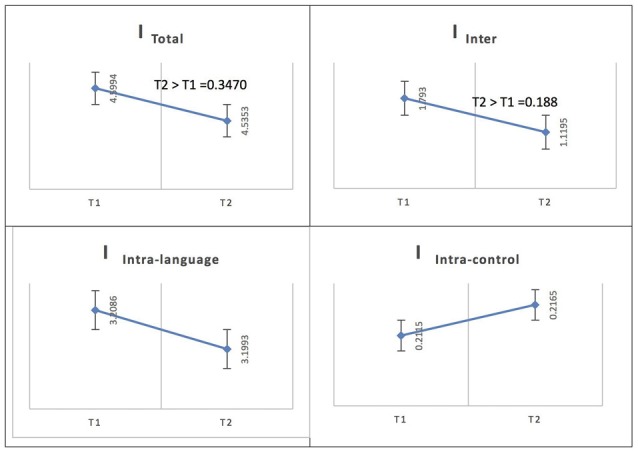
Probability value of the network integration differences between L1 and L2 (French) in the Spanish-speaking group. I = integration, ITotal = total integration value, IIntra_L = Intra-integration of language areas, IIntra_C = Intra-integration of cognitive control areas and IInter = integration between the two networks (language processing and cognitive control). A probability greater than 0.9 is considered significant.